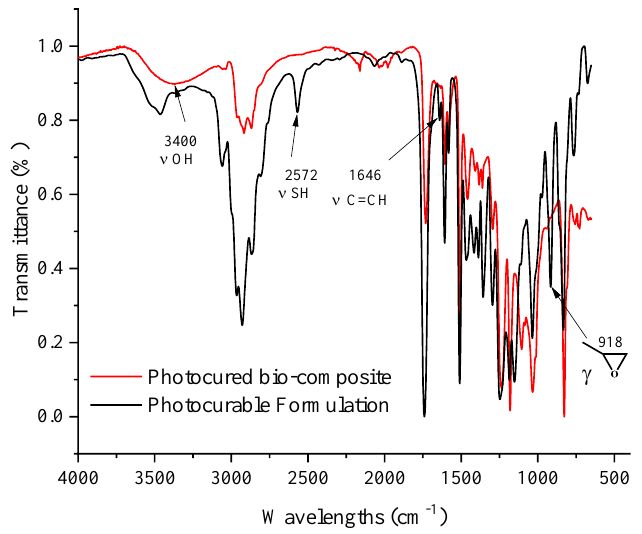
Figure 5. Comparison of the FTIR spectra of the photocurable formulation before UV irradiation and of the polymeric matrix of the bio-composite. ν and γ stands for stretching and bending bands.